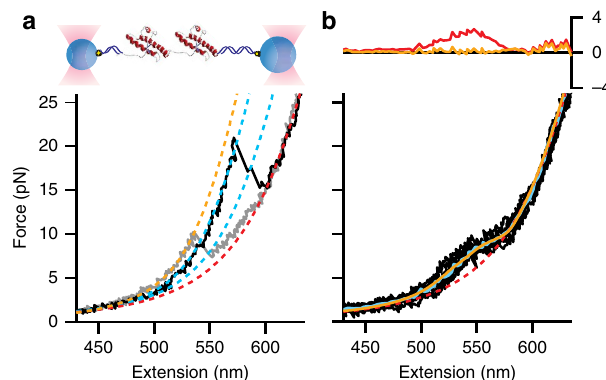
Figure 4 | FECs of PrP dimer. ( a ) Inset: schematic of tandem dimer. FECs without Fe-TMPyP (grey) reveal a total D L c more than twice the value for isolated monomers, indicating that the dimer forms a stable, non-native state. With 50 m M Fe-TMPyP (black), some FECs unfolded in two steps, each having the same D L c as for unfolding PrP C , indicating that both domains were natively folded. Dotted lines: WLC fits (yellow, misfolded dimer; red, unfolded; cyan, natively folded domains). Total number of FECs: 164. ( b ) Most FECs with 50 m M Fe-TMPyP (black) showed no discrete transitions. The average (cyan) deviated markedly from a simple WLC model (red), but was well fit by the same model as for Fig. 3 (yellow). Inset: fit residuals.